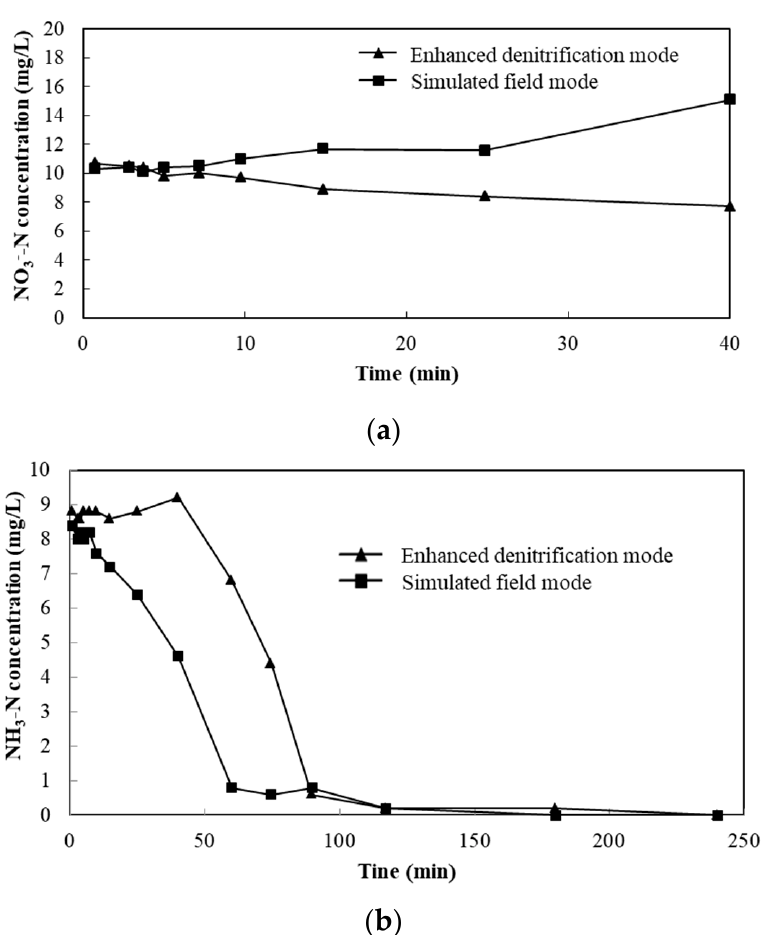
Figure 9. ( a ) Nitrate variation by simulation and optimization in the CAST process; ( b ) Ammonia nitrogen variation by simulation and optimization in the CAST process.